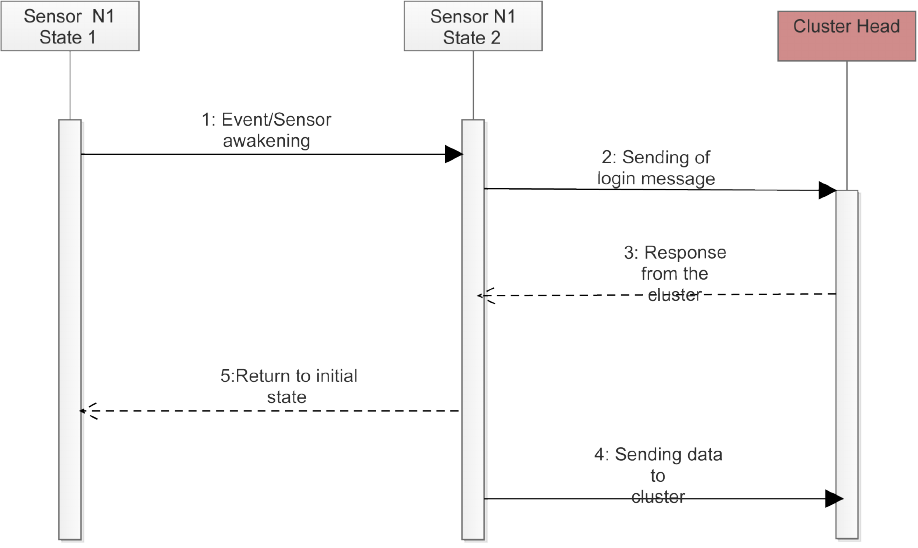
Figure 5. Diagram of activity sequences of first level architecture